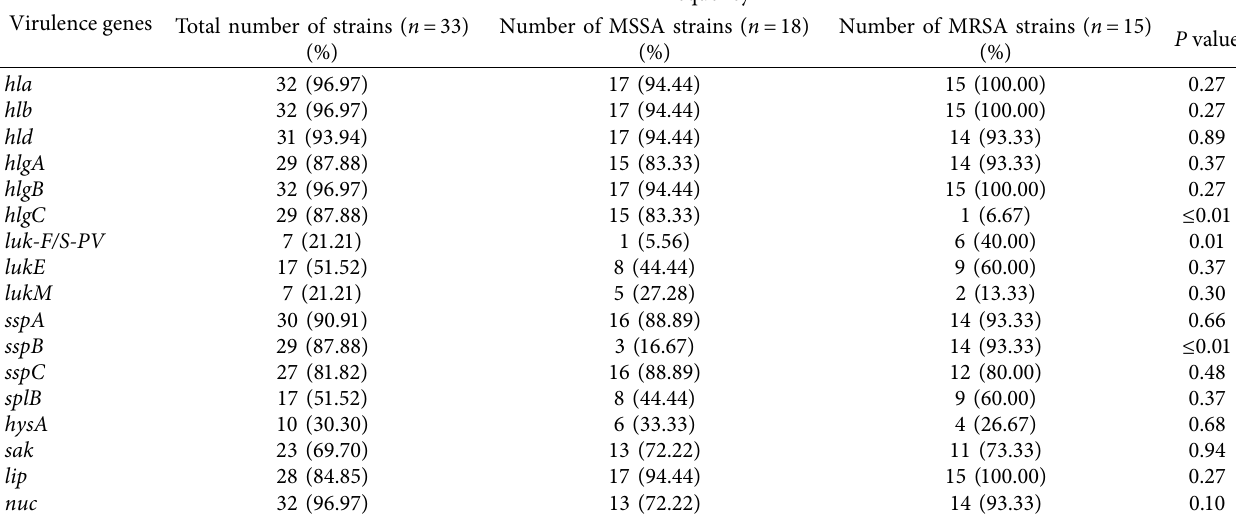
Table 3: Distribution of virulence genes among MSSA and MRSA strains (%).